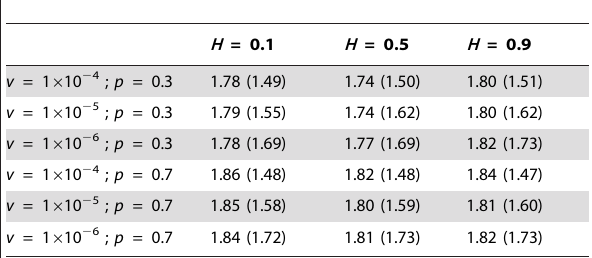
Table 1. Fractal species